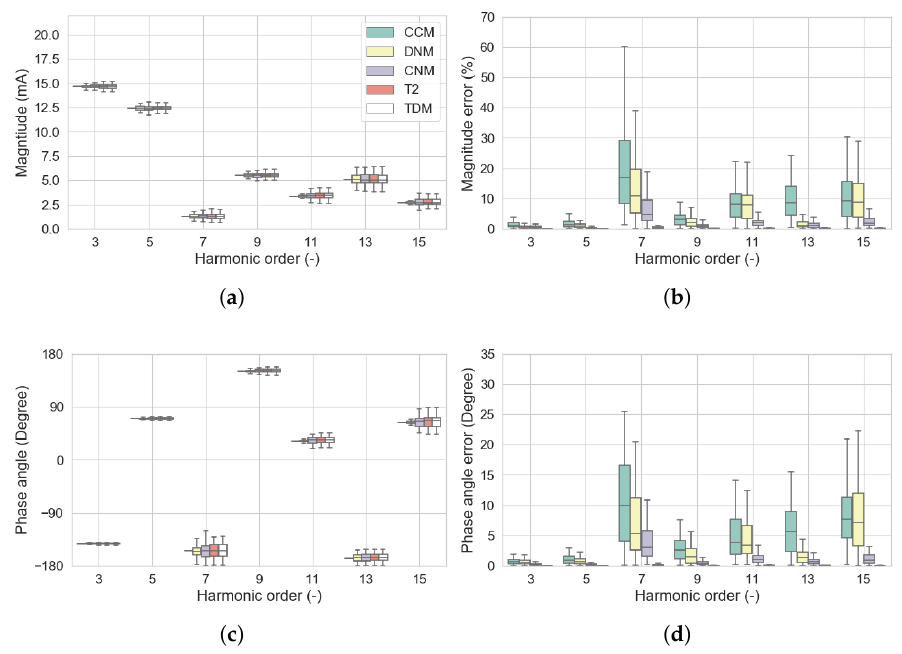
Figure 13. Comparison of the Type B LED lamp frequency domain models for peak-top voltage supply: ( a ) Magnitude; ( b ) Magnitude error; ( c ) Phase angle; and ( d ) Phase angle